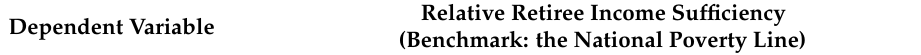
Table 9. Retiree relative income sufficiency decomposition in Australia and New Zealand (compared with the national poverty